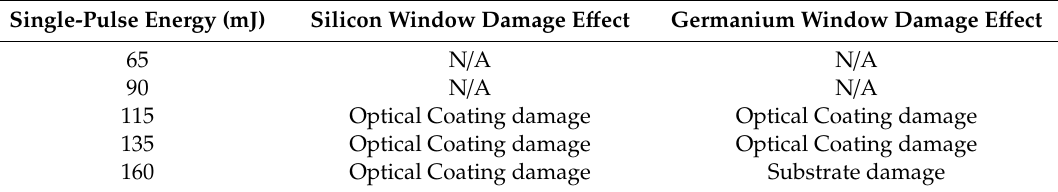
Table 7. Experimental results of the short-pulse